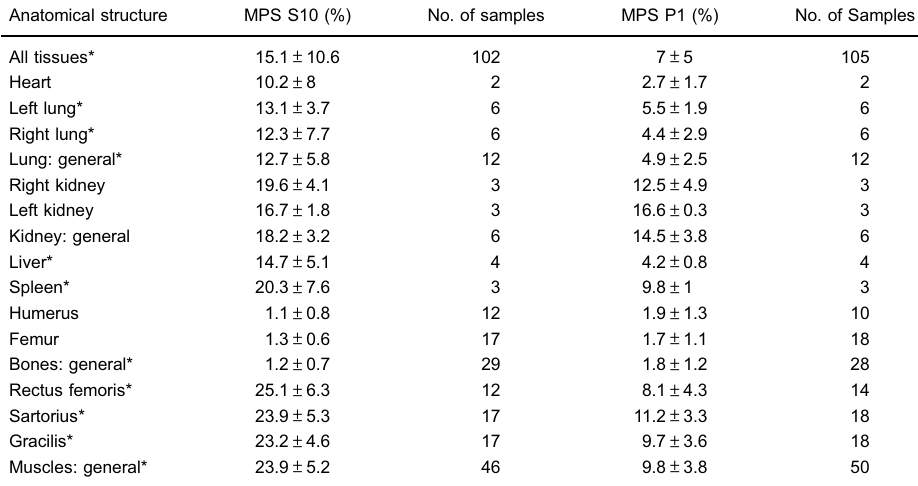
Table 2. Mean percent shrinkage (MPS) ± SD per organ/tissue (area